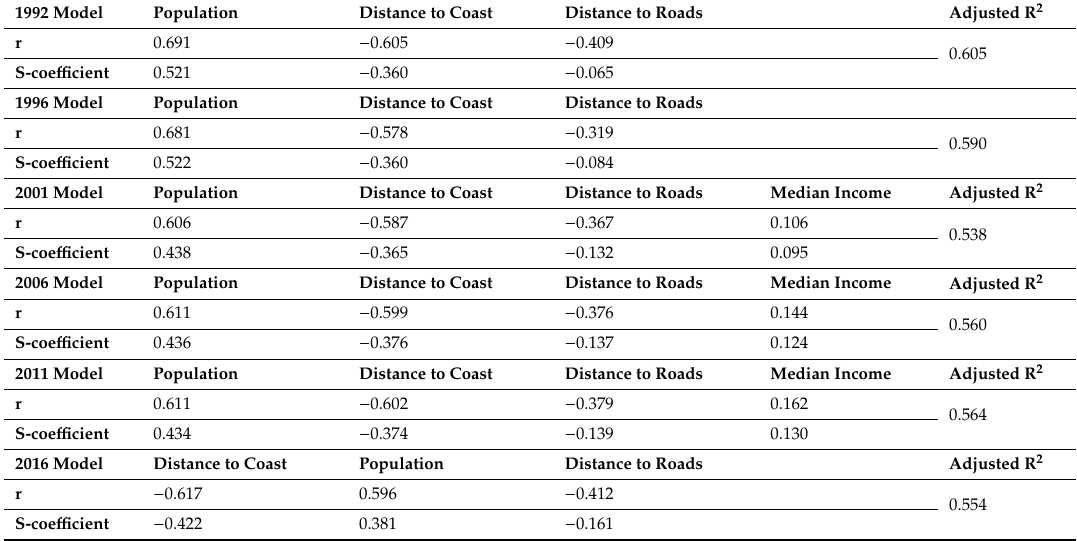
Table 5. Summary of the multiple linear stepwise regression models. For each of the six models, the dependent variable (urban land area in 1 km 2 grid) was explained by four variables. The sequence of the explanatory variables in each model is the order these variables entered the regression models. S-coe ffi cient means standardized coe ffi cients, which could be used to determine the relative significance of explanatory variables. r means Pearson Correlation Coe ffi cient, which indicates the state (positive / negative) and the level (weak / strong) of correlation of dependent variable and explanatory variables. All the values are statistically significant at 0.001 level